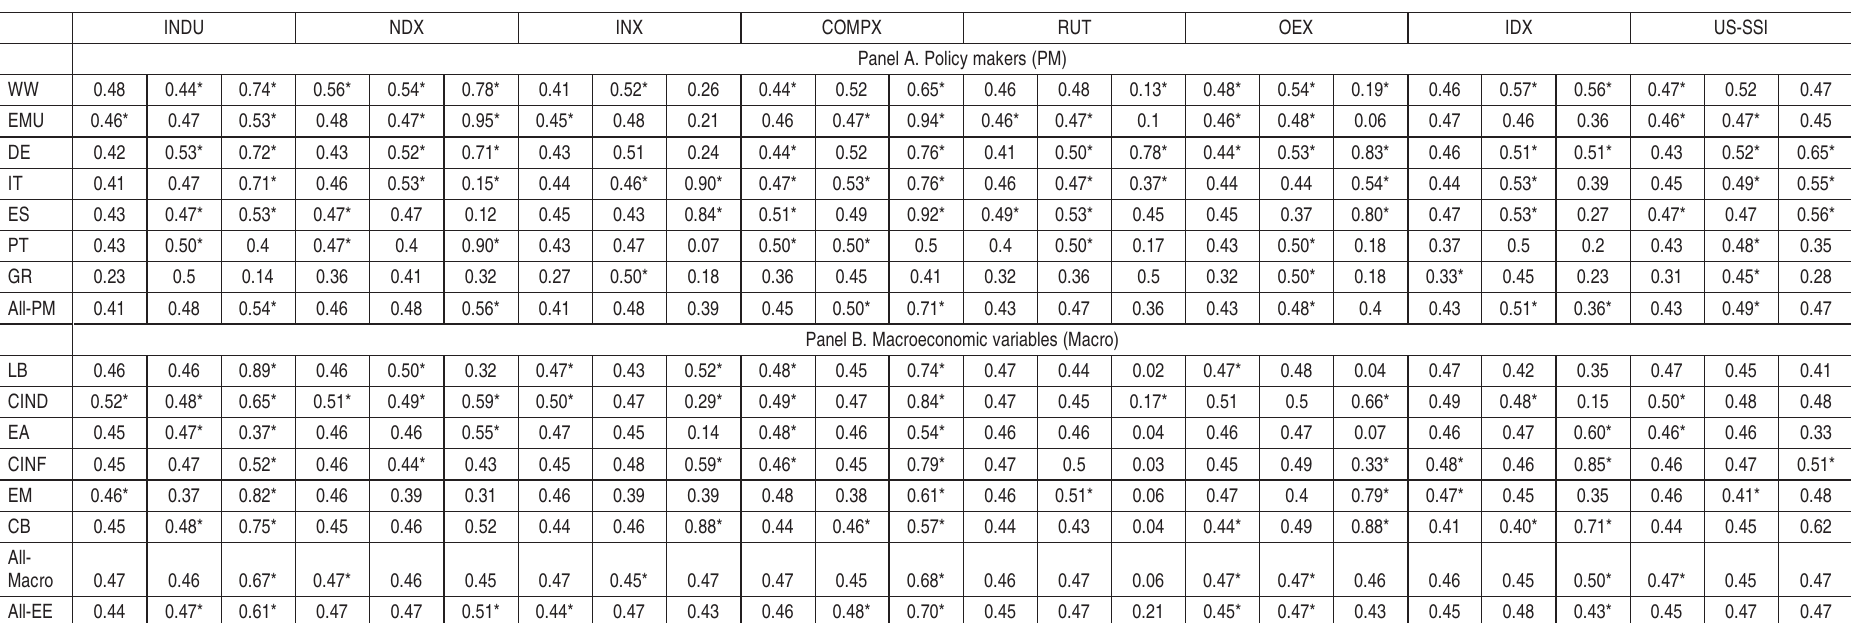
Table 3. Sharpe ratio - US stock spot indices (US-SSI)